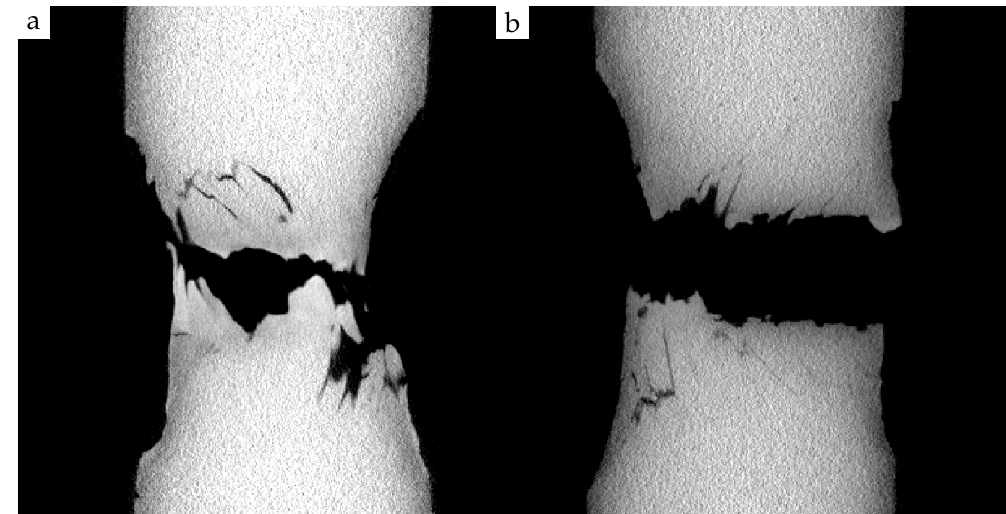
Figure 18. Fractography images from within the weld seam of AISI430Ti after ( a ) 10h and ( b ) 20h exposure to the corrosive environment, obtained by µ -CT